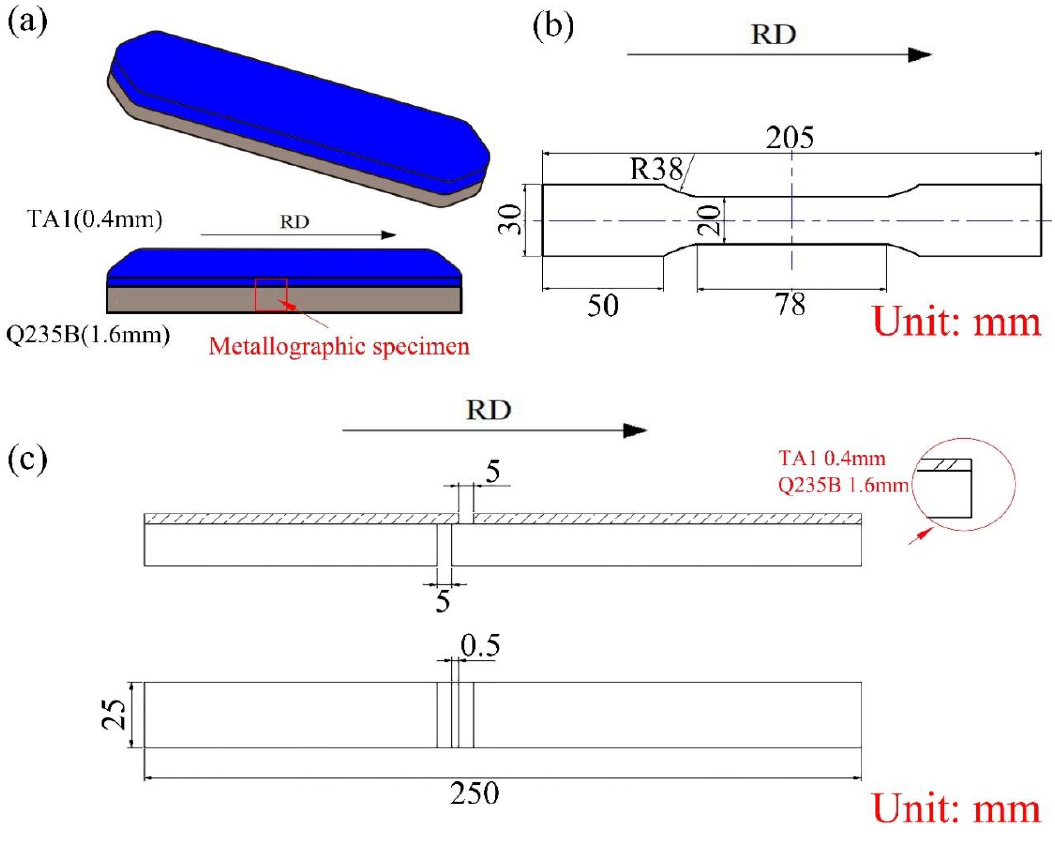
Figure 2. Schematic diagrams of specimen for ( a ) metallographic specimen, ( b ) tensile test, and ( c ) tensile shear test.